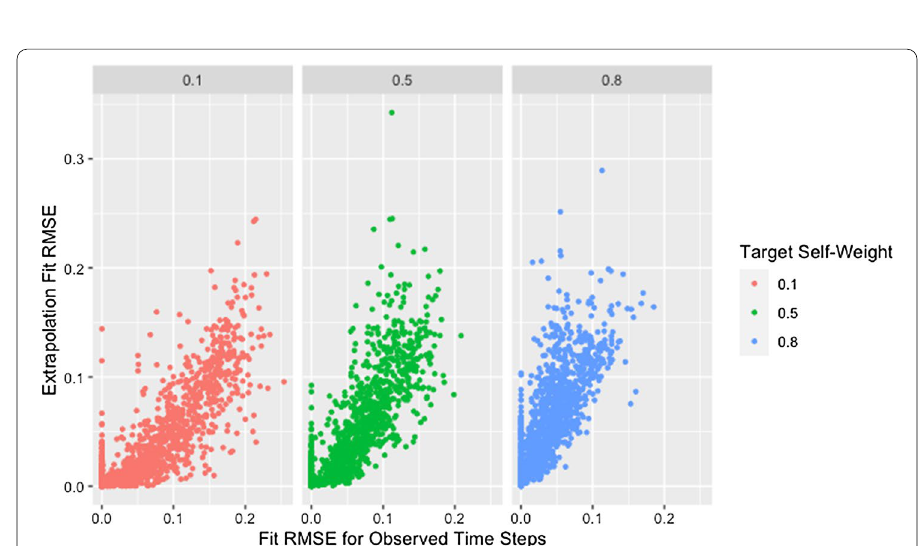
Fig. 16 Extrapolation RMSE by fit RMSE and self-weight. RMSE for observed and predicted opinions on extrapolated time steps by RMSE for observed and predicted opinions on observed time steps and target